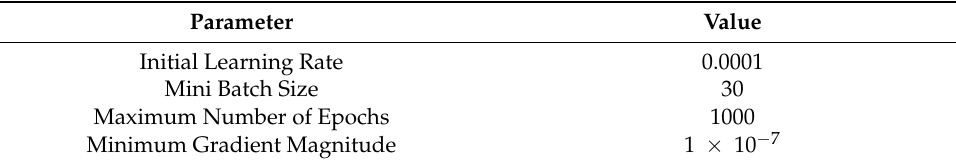
Table 1. DCNN model parameters